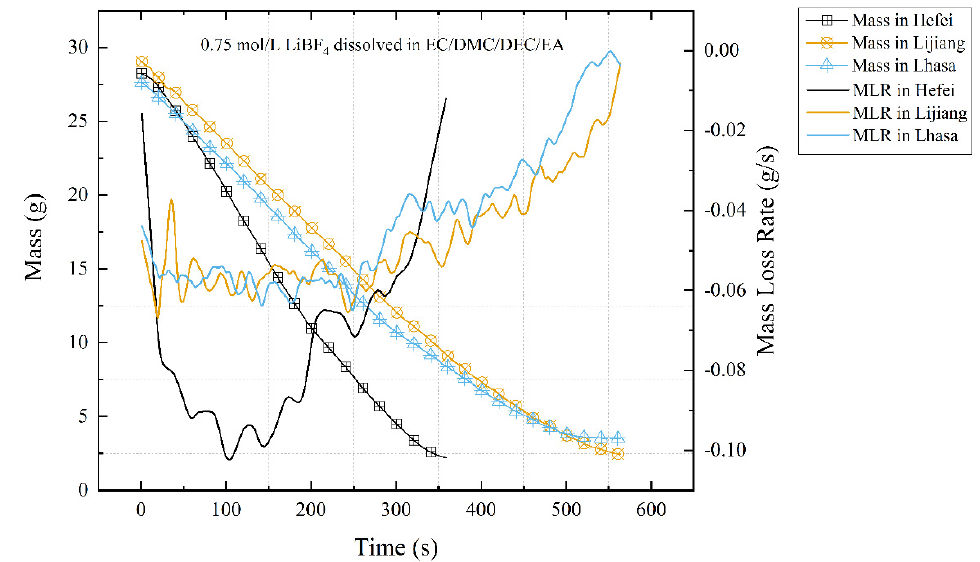
Figure 8. Mass and MLR changing curves of the electrolyte with LiBF 4 at di ff erent altitudes: mass in Hefei (black square), mass in Lijiang (yellow circle), mass in Lhasa (blue triangle), MLR in Hefei (black line), MLR in Lijiang (yellow line) and MLR in Lhasa (blue